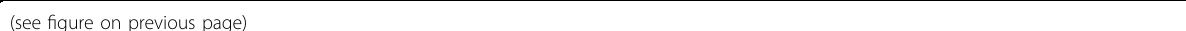
Fig. 4 The siRNA-mediated knockdown of LYVE-1 in HSC-3 cells. a , b The qPCR and western blot analyses showed a clear attenuation of LYVE-1 in the silenced HSC-3 cells. Three Silencer Select Validated siRNAs for silencing LYVE-1 (IDs s21402, s21403 and s21404) were tested along with one negative control siRNA (cat no. 4390843, all were Ambion by Life Technologies, Carlsbad, CA, USA) in two different fi nal concentrations, 10 and 50 nM. The siRNA sequences were as follows: (1) s21402: sense 5 ′ -GGAUUUUGCUAUGUCAAAAtt, antisense 5 ′ -UUUUGACAUAGCAAAAUCCaa; (2) s21403: sense 5 ′ -CCAAAGUAGUAAAGGAGGAtt, antisense 5 ′ -UCCUCCUUUACUACUUUGGtt; and (3) s21404: sense 5 ′ -CAACCCUAAUGAGGAAUCAtt, antisense 5 ′ -UGAUUCCUCAUUAGGGUUGct. For analysis of LYVE-1 gene expression, 15 × 10 4 HSC-3 cells per well were plated on a 24-well plate in duplicates for each siRNA and concentrations. The next day the cells were transfected according to the manufacturer ’ s protocol with the help of Lipofectamine RNAiMAX (Invitrogen) transfection reagent. After 48 h of transfection, the RNA was extracted with TRizol Plus RNA Puri fi cation Kit (Ambion) along with